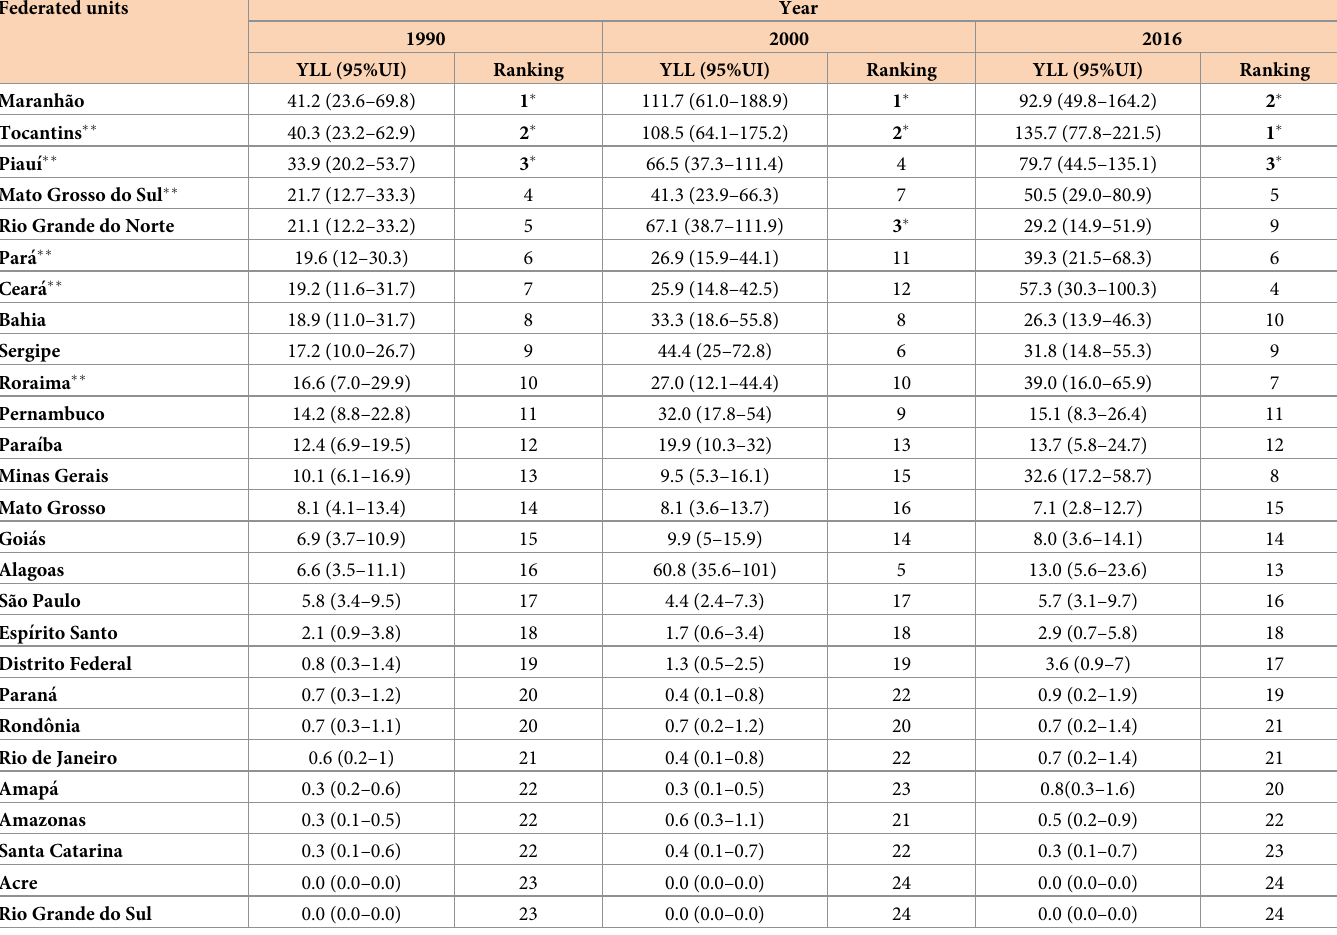
Table 2. Age-standardized rates of years of life lost (YLL) per 100,000 inhabitants for Visceral Leishmaniasis considering the Brazilian federated units between 1990 and 2016, GBD Study 2016. Federated